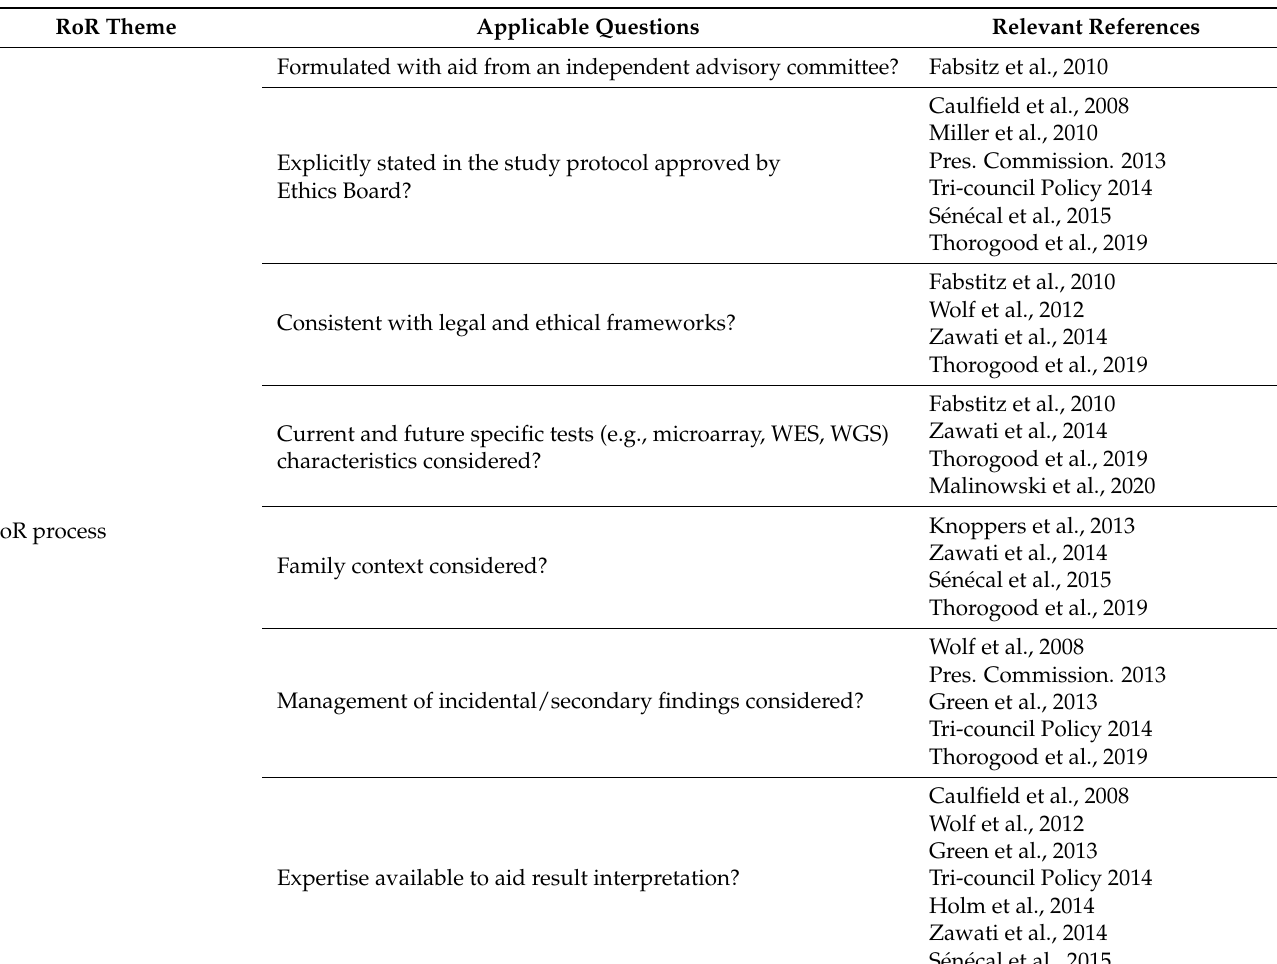
Table 1. Summary of existing recommendations and discussions on the return of genetic results. RoR